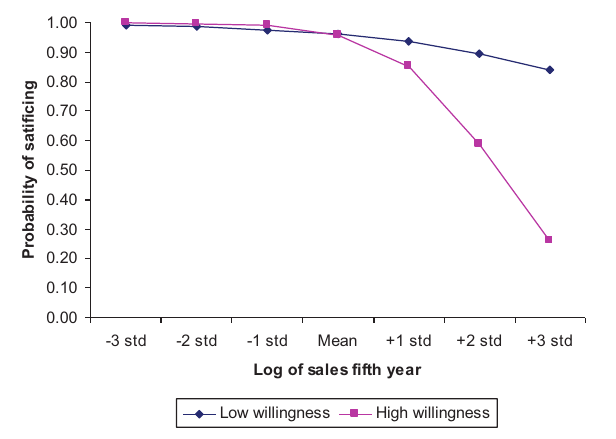
FIGURE 2 | Interaction of willingness to become entrepreneurs and wealth aspiration level on probability of satisficing *. *Probability is calculated by using exp(y)/{1 + exp(y)} while y = constant – 0.14*logsale5 + 4.00*willingness –0.31*logsale5*achievement. We set willingness as 3.15, i.e., one STD (1.17) above the mean (1.98) and low achievement as 0.81 one STD below the mean. Constant is set to